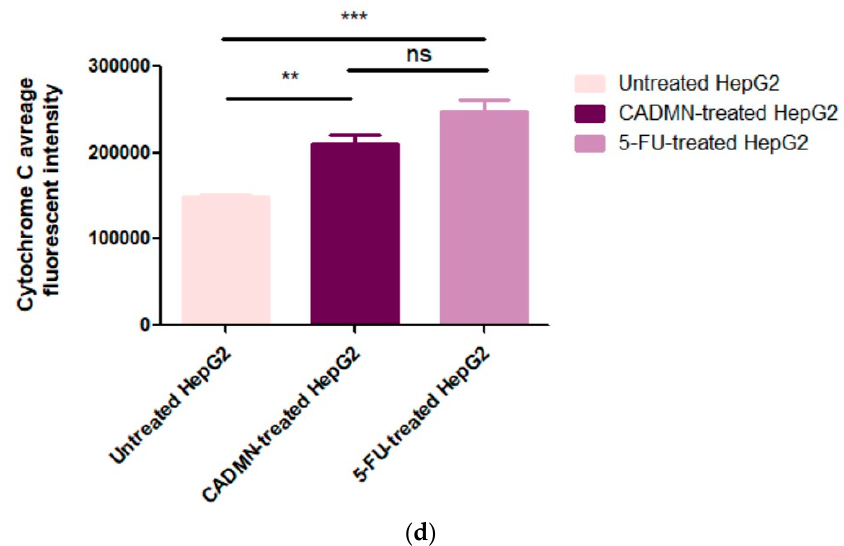
Figure 6. ( a ) Effect of CADMN and 5-FU on nuclear condensation (Hoechst 33342, blue) and cell membrane permeability. (YoYo dye, green), release of cytochrome C (yellow) and mitochondria outer membrane permeabilization (MOMP, MitoTracker, red) dyes. 5-FU was used as a positive control. Microphotographs were captured with a Leica Confocal microscope, magnification 20 × and scale bars 100 µ m. CADMN and 5-FU led to damage and increase in mitochondrial outer membrane permeabilization (MOMP) as indicated by decreases in Mitotracker dye uptake ( b ), increase in cell permeability ( c ), and leakage of cytochrome C from mitochondria to cytosol ( d ). Data were presented as mean ± SD. ** p < 0.01, *** p < 0.001 indicate significant di ff erence as compared to control untreated